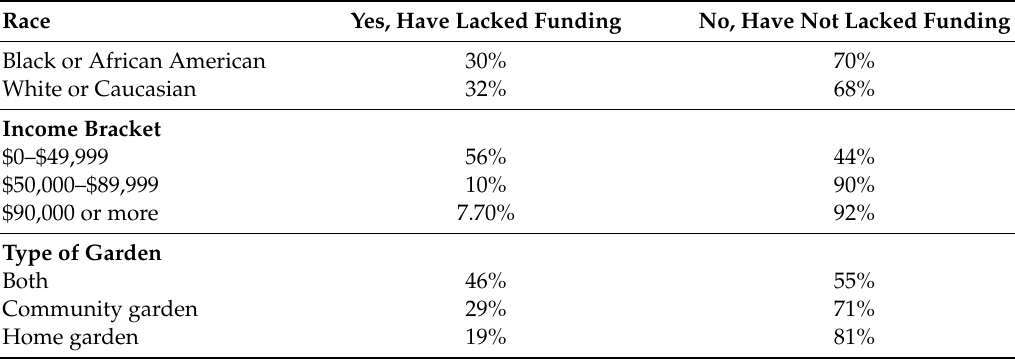
Table A13. Lack of funding to remediate heavy metal soil contaminants and / or slag.